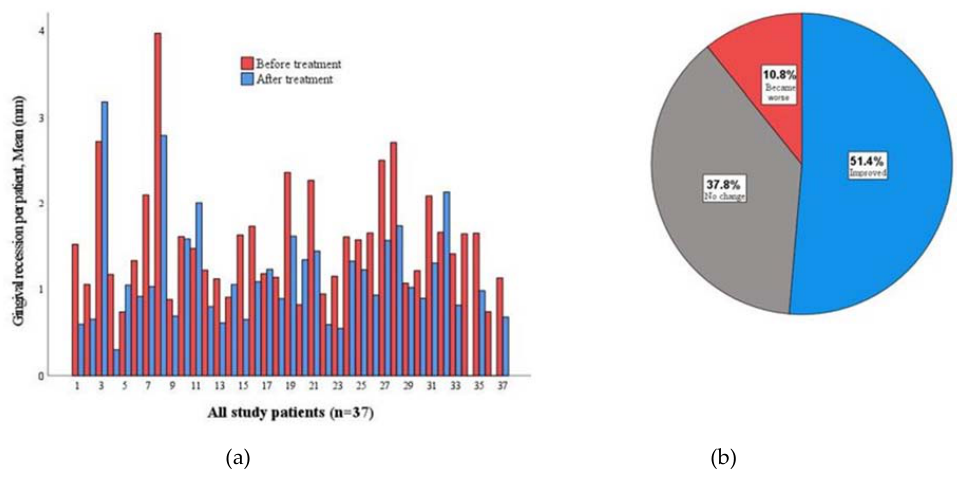
Figure 5. Comparison of gingival recession (GR) change before and after (OT) at patient level. ( a )— mean GR change before and after OT in every study patient; ( b )—percentage of patients with GR change after OT (the cut-off value defining improvement or worsening was 0.5 mm). As significant GR change at patient level was found, the influence of specific patient and treatment factors were